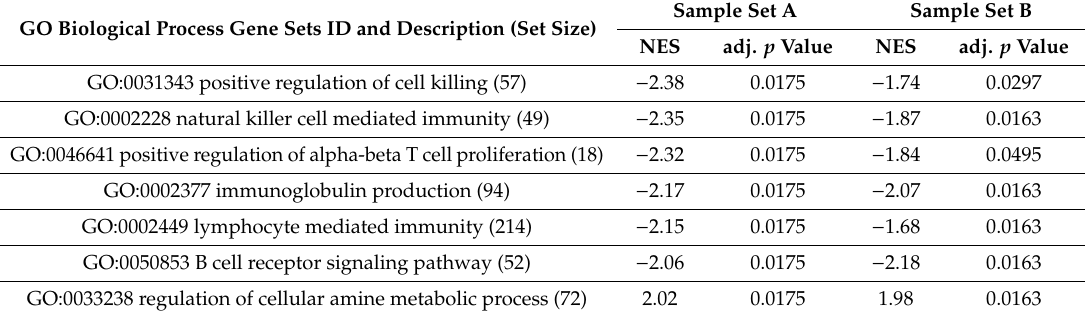
Table 3. Selected significant Gene Ontology Biological Process gene sets. Only gene sets significant in both Sample set A and validation Set B were listed and limited to gene sets with absolute NES above 2.0 in Sample Set A, after the exclusion of redundant